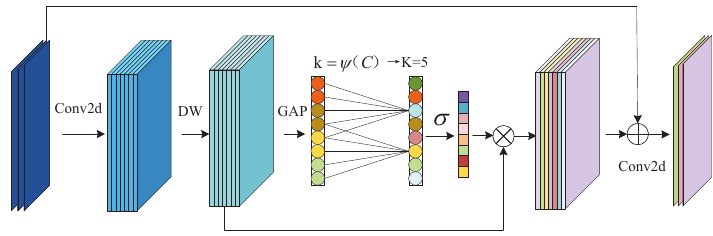
Figure 5. The linear bottleneck with the ECA